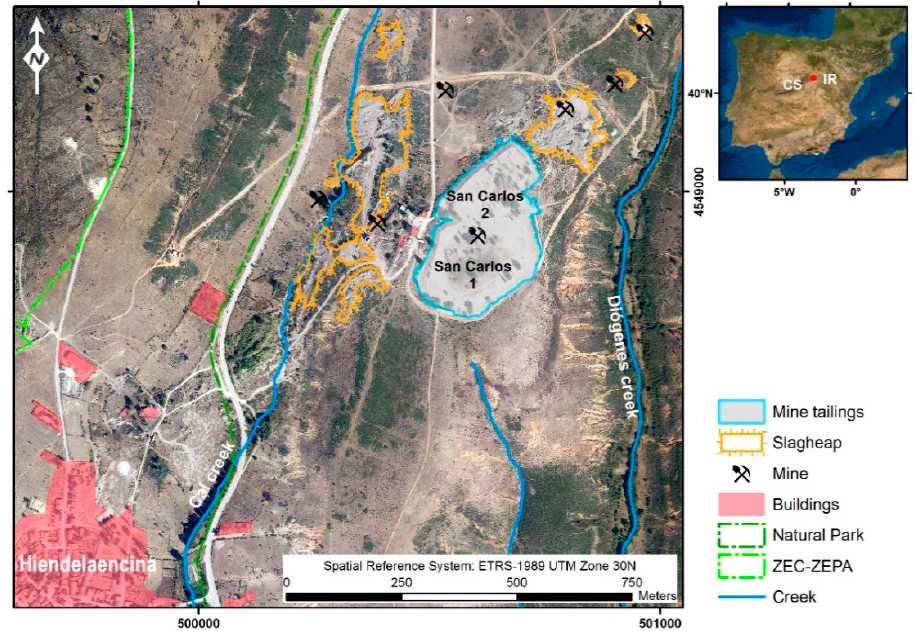
Figure 1. Location of the sludge ponds and other elements of the San Carlos mine on the orthophoto of the 2018 flight (Vector data source [30,31]). ZEC-ZEPA, Zone of Special Conservation–Zone of Special Bird Protection. The red circle in the regional map locates the study area. CS, Central System. IR, Iberian Range.